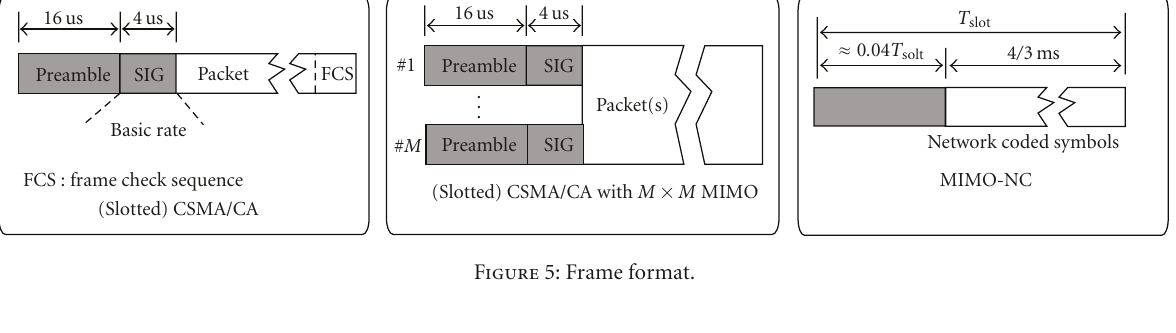
Figure 5: Frame format.